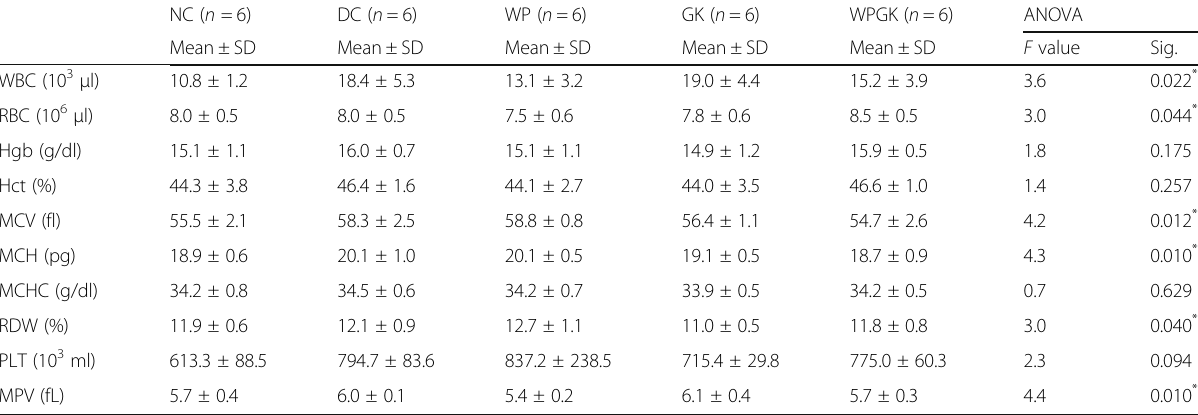
Table 2 Mean ± SD of hematological parameters of diabetic rats fed on whey protein, G. kola , and their